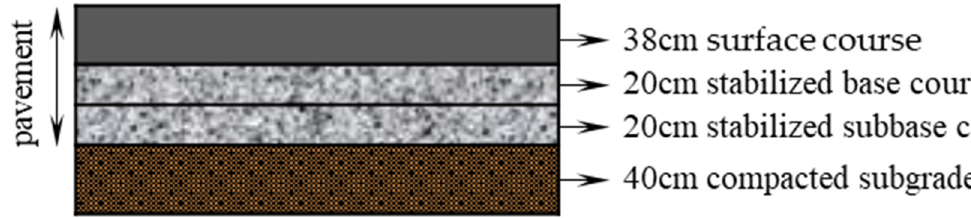
Figure 2. Structure of the airport rigid pavement.